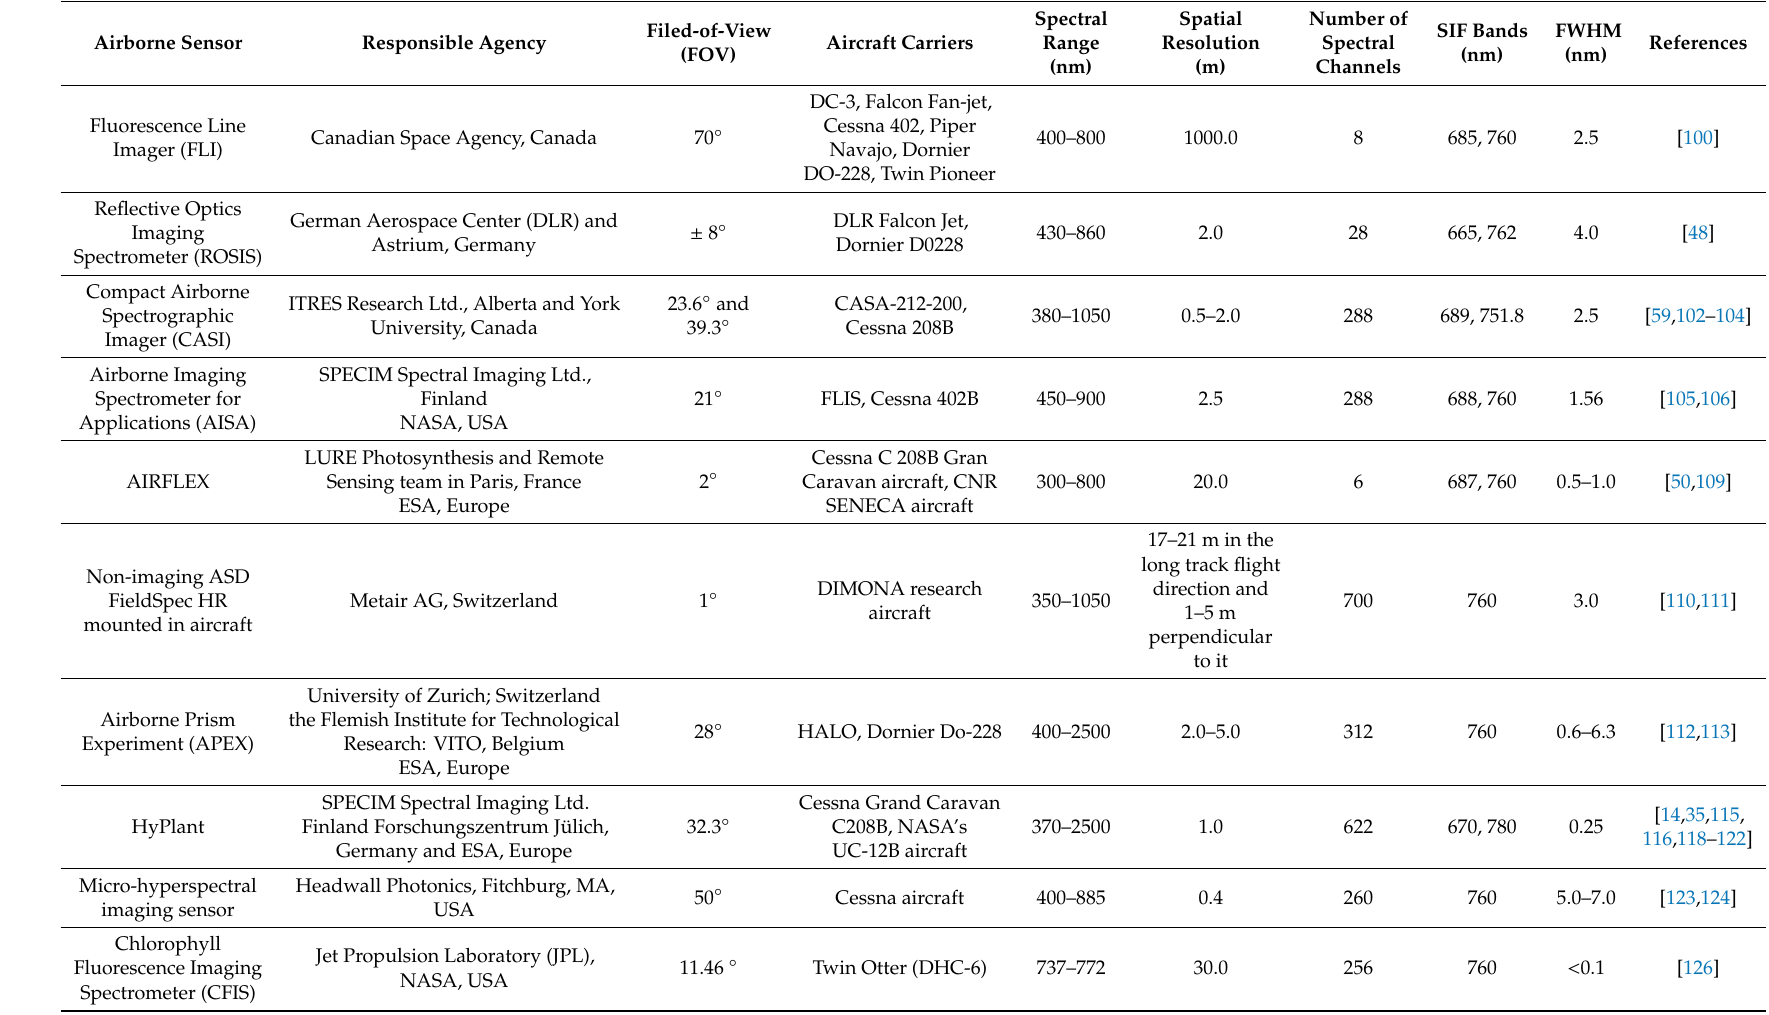
Table 3. Summary of the airborne platforms and systems used for SIF estimations until